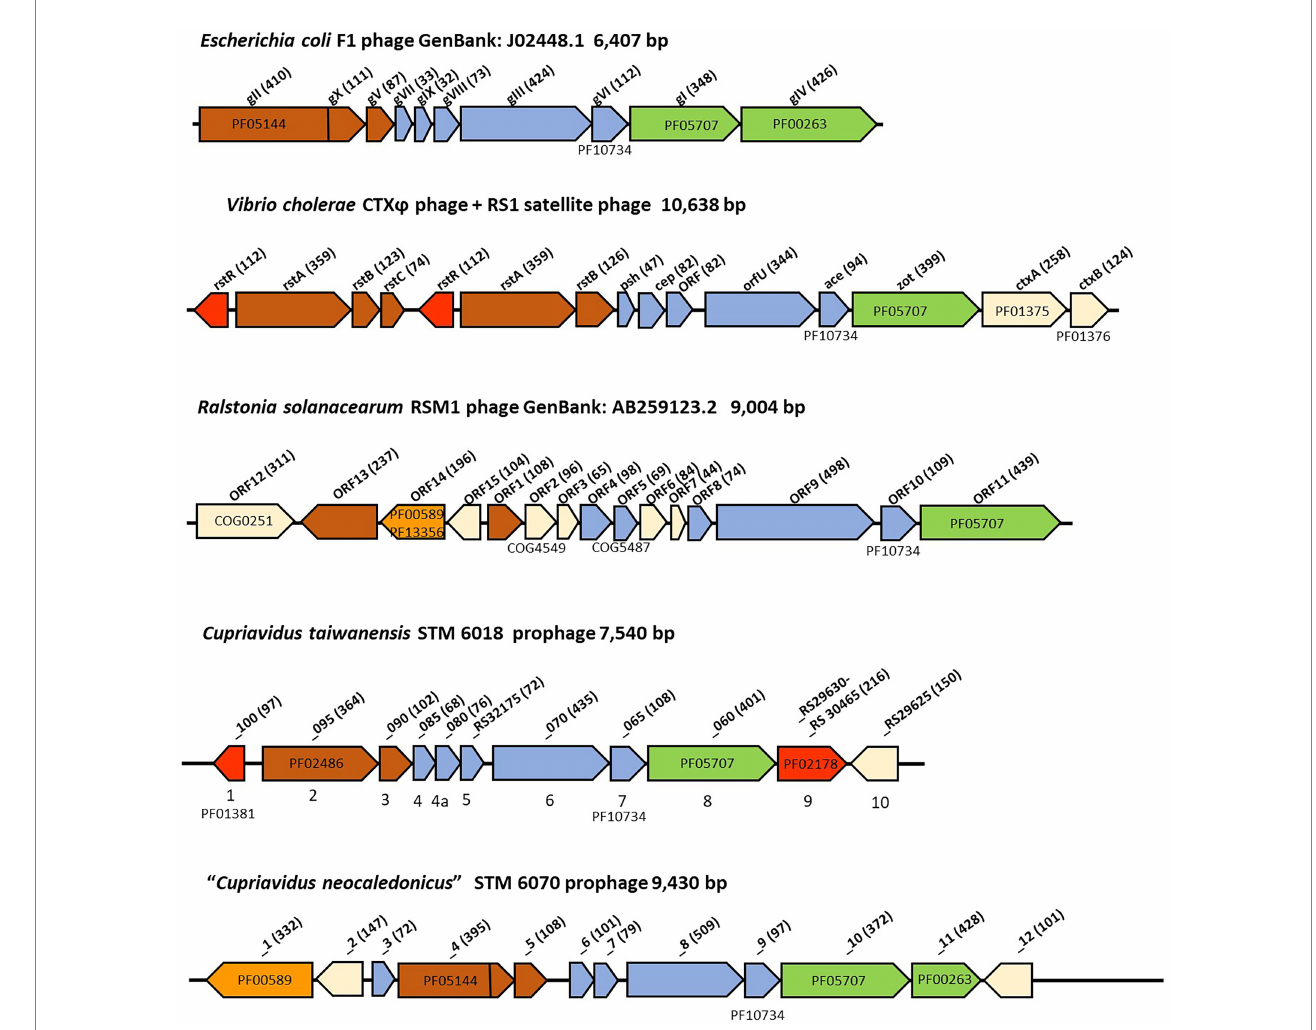
FIGURE 4 Comparison of filamentous phage genomes. The genes are colored according to function, where red indicates regulatory genes, brown indicates replication genes, orange indicates genes encoding integrases, blue indicates structural genes, and green indicates assembly and secretion genes. White indicates genes that are unique for each phage. The amino acid sequence length of the encoded proteins is in brackets. Where relevant, COG and pfam numbers of the encoded proteins are